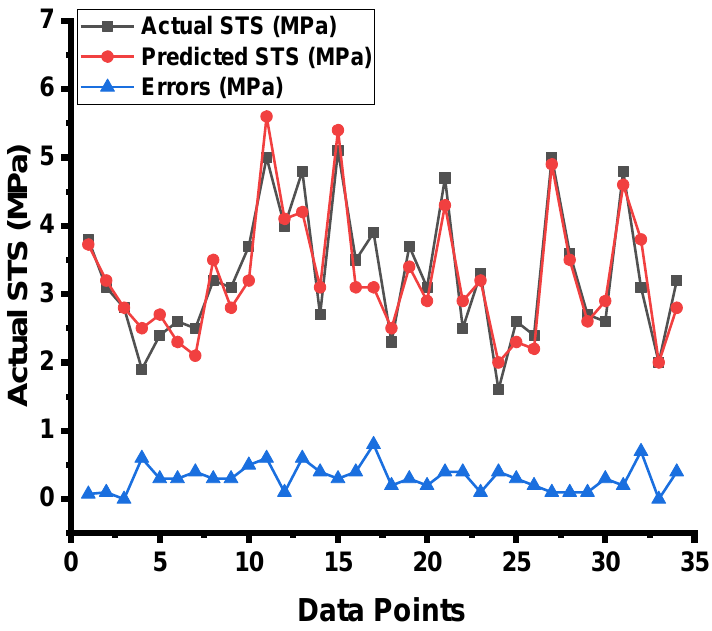
Figure 10. DT model ’s actual results, predictions, and dispersal of their difference.